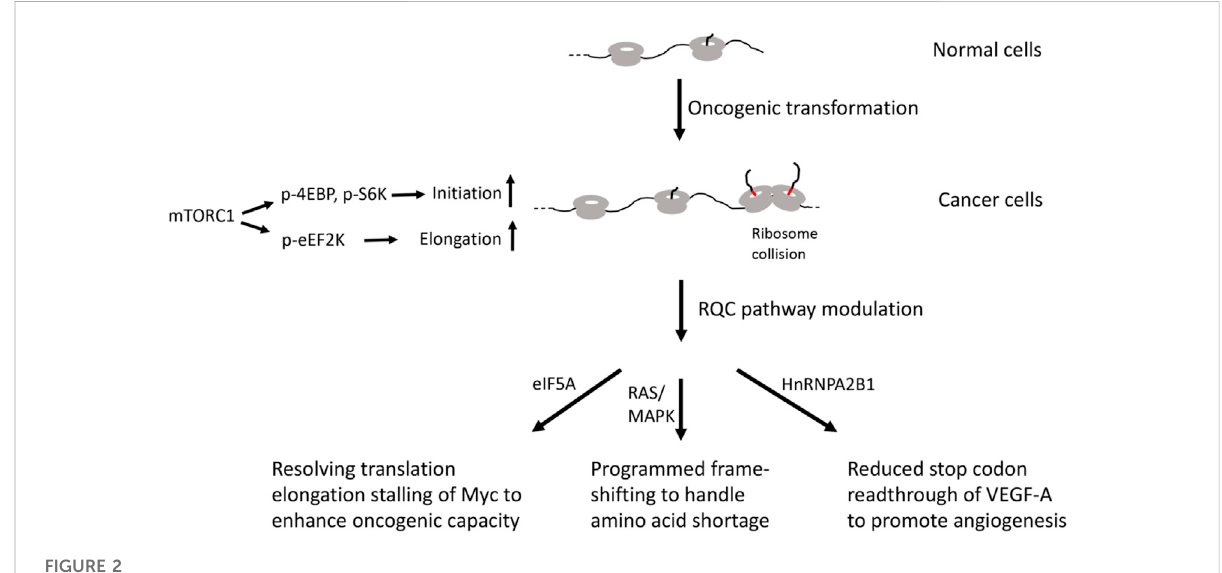
FIGURE 2 Diagram depicting possible involvement of RQC factors in